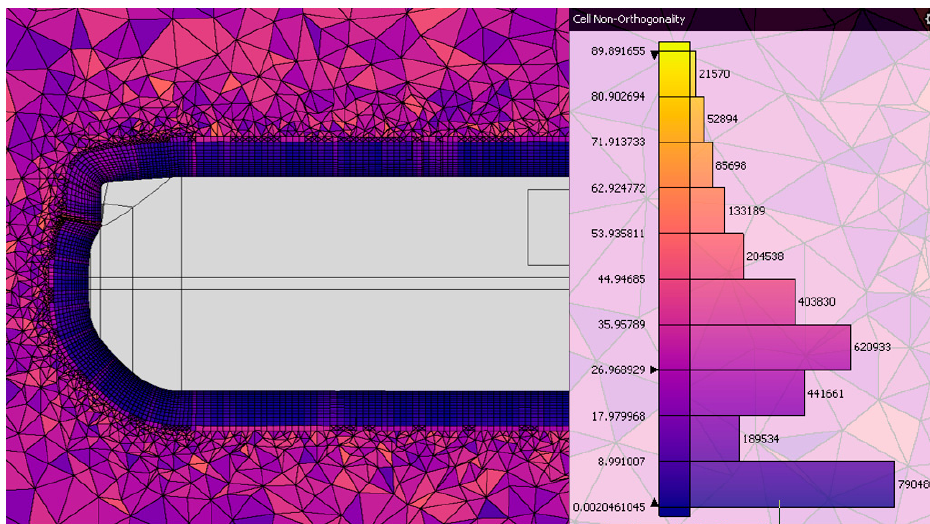
Figure 7. Surface grids generated based on the CAD model of SST hull: ( a ) side view, ( b ) zoom in at the front region, and ( c ) zoom in at the back region.